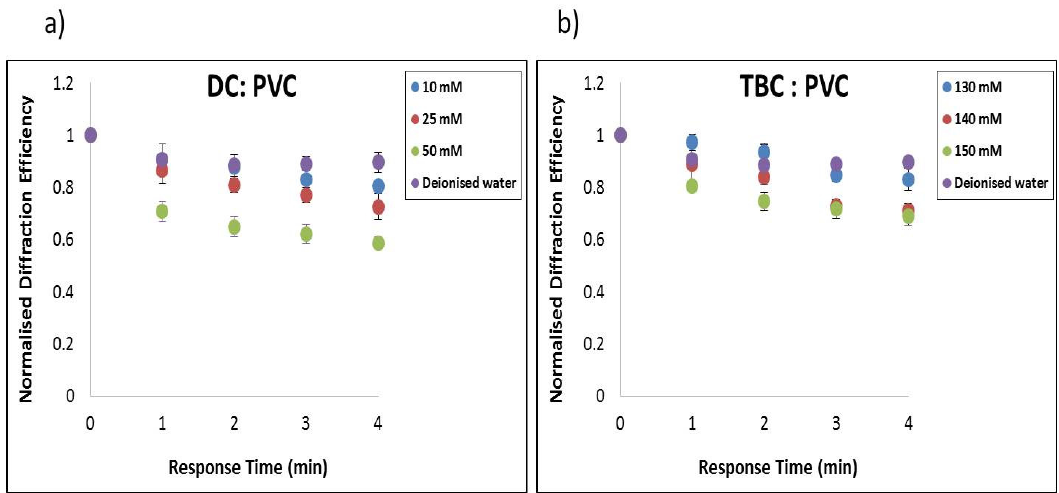
Figure 9. Normalised diffraction efficiency change response DC and TBC plasticised PVC photonic structures ( a ) KCl exposure to (10–50 mM) ( b ) NaNO 3 exposure to physiological levels (130–150mM)